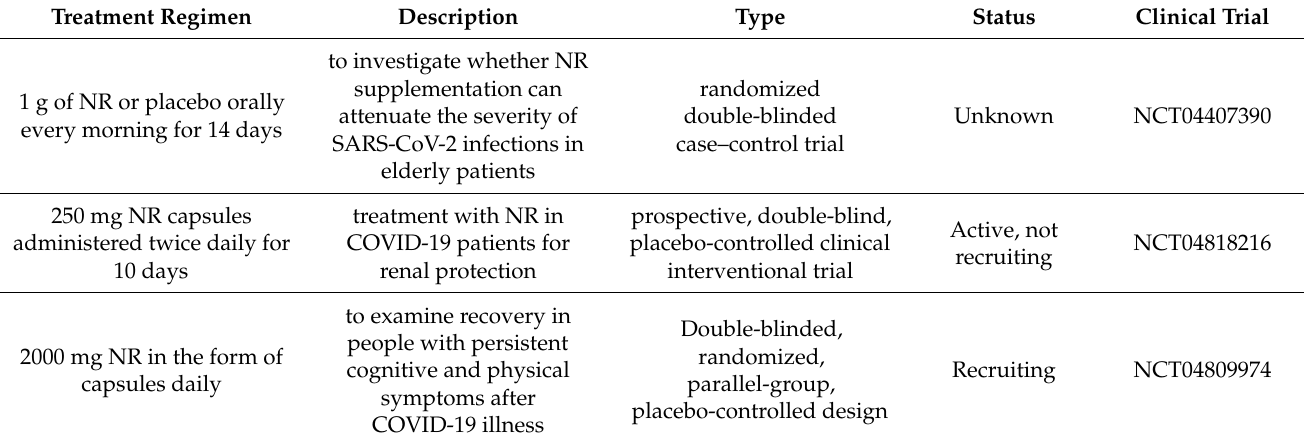
Table 2. Clinical trials of NR in